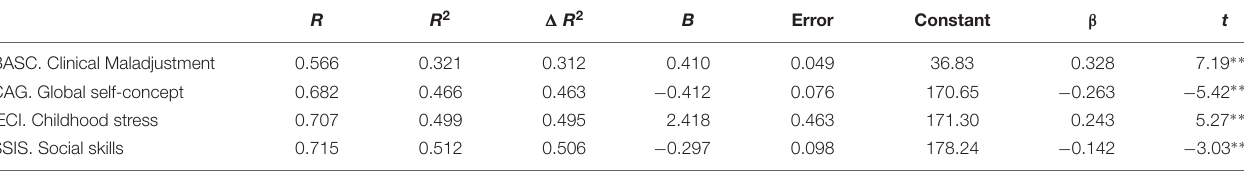
TABLE 3 | Multiple regression analysis for global dimensions predictive of childhood depression.